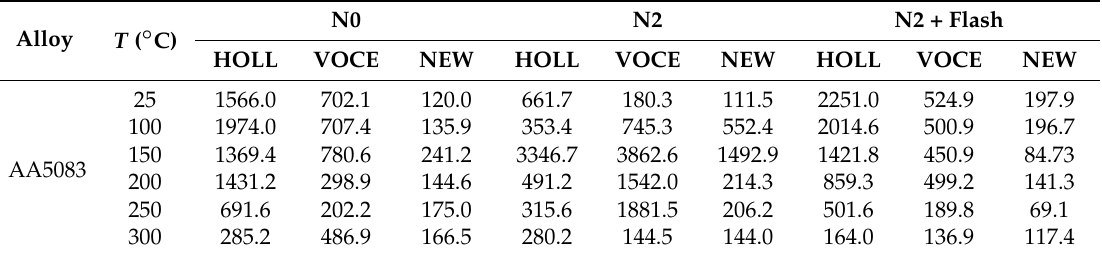
Table 15. Error of each flow rule obtained for AA5083 in relation to the experimental curve (N).